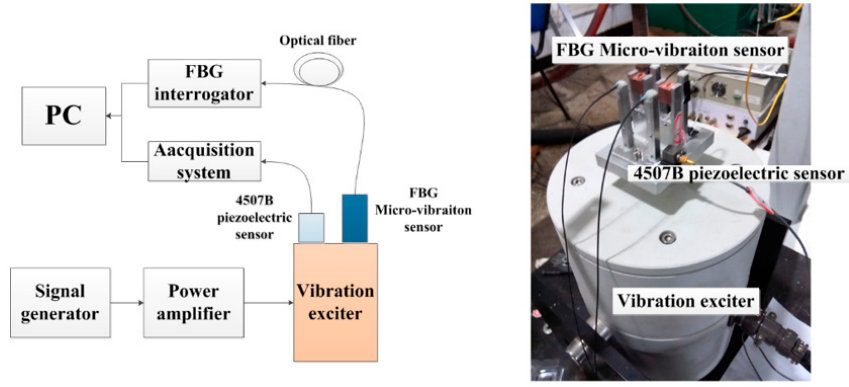
Figure 5. Schematic diagram and physical map of the experiments to determine the sensors’ sensing properties.